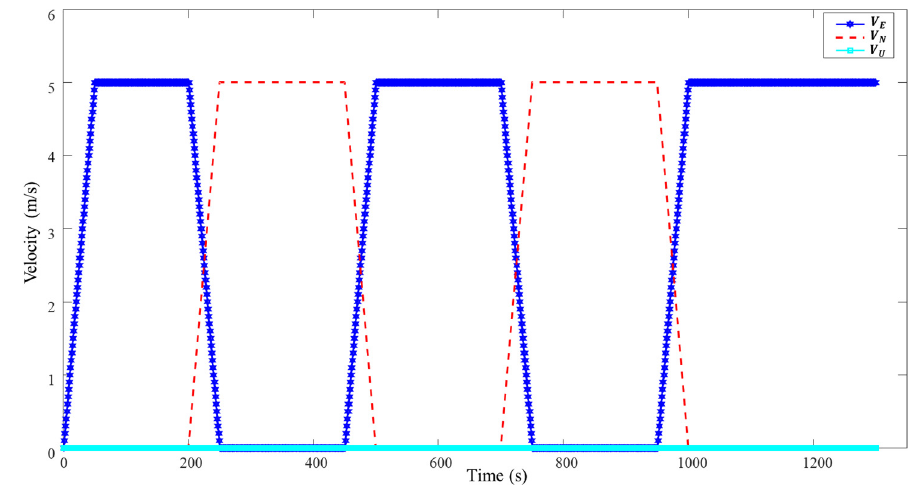
Figure 6. Velocity variation of AUV. Table 1. Main performance parameters of the sensors.